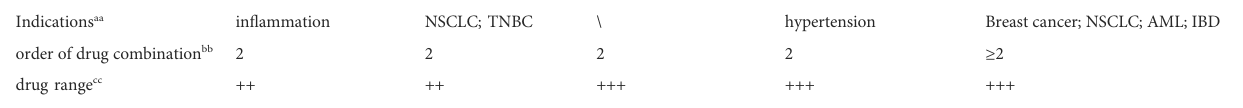
TABLE 4 Comparison of different